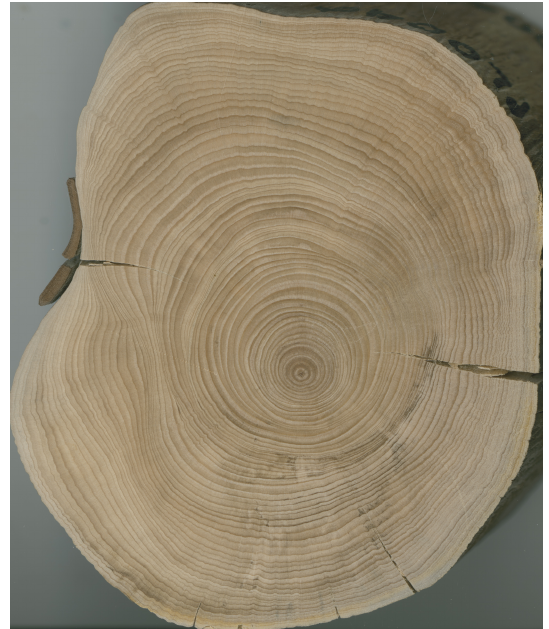
Figure 3. P. lawrencei specimen from Mt Loch, demonstrating typ- ical lobate growth behaviour and ring